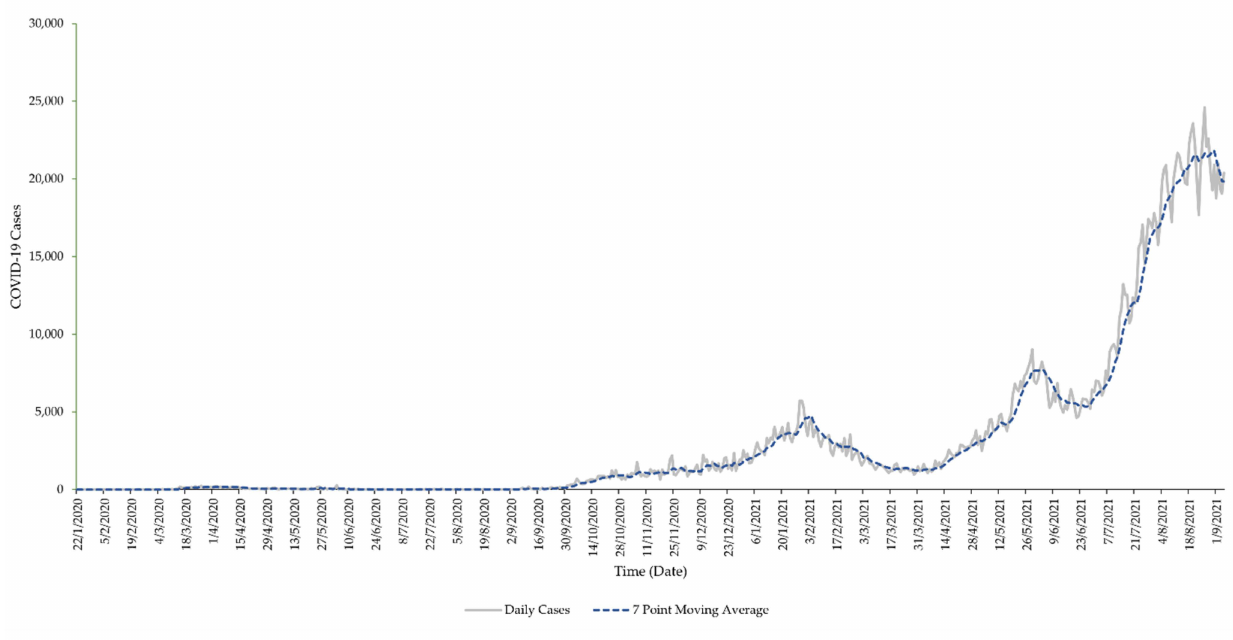
Figure A1. COVID-19 case trends (22 January 2020–5 September 2021),